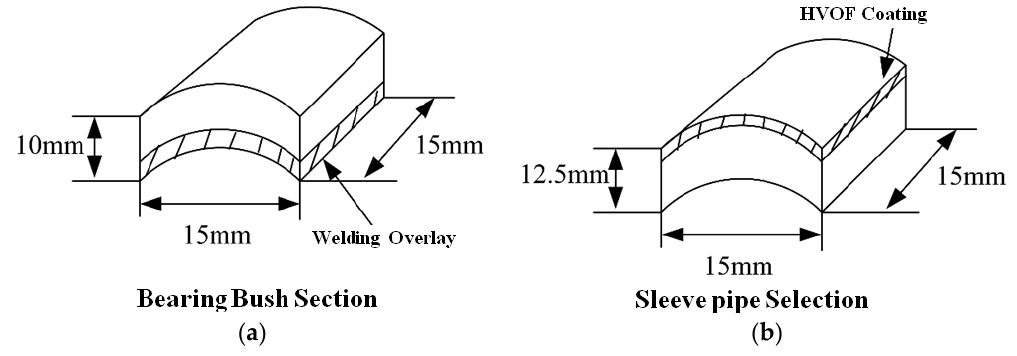
Figure 2. Schematic illustration of the specimen dimensions: ( a ) bushing with Co ‐ Cr alloy coating and ( b ) sleeve pipe with Co ‐ Cr ‐ Ni+WC coating.